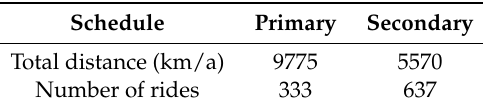
Table 2. EV schedule